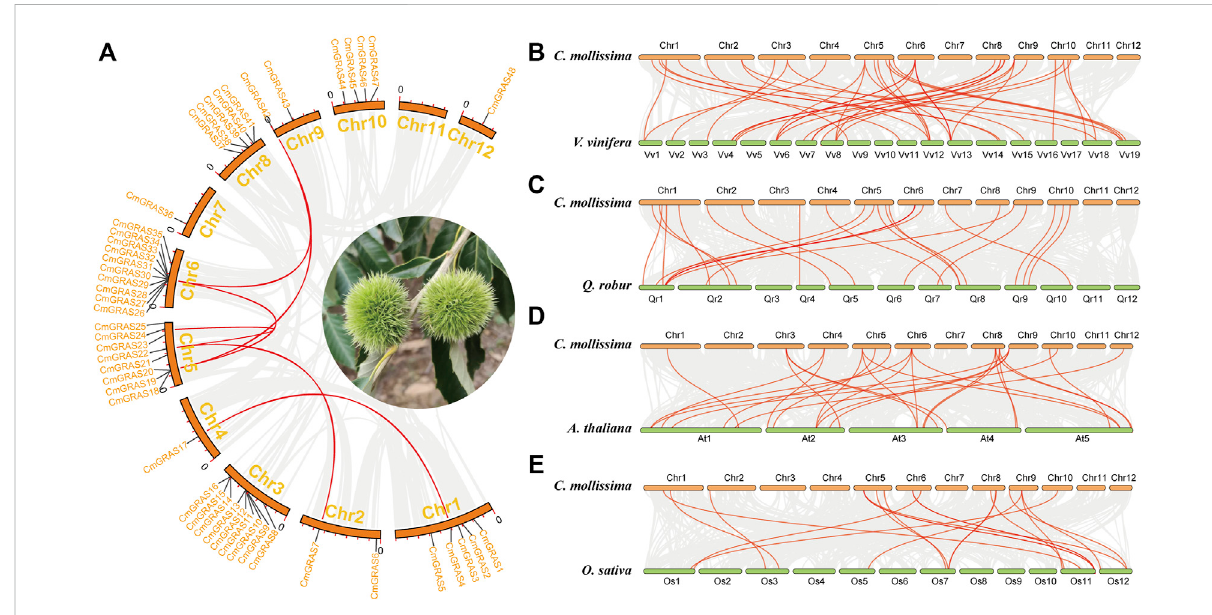
FIGURE 3 Collinear relationships within Chinese chestnut genome and with the grape, oak, Arabidopsis thaliana and rice genomes. (A) Collinear relationship within Chinese chestnut genome. (B) Collinear relationship between Chinese chestnut and grape genomes. (C) Collinear relationship between Chinese chestnut and oak genomes. (D) Collinear relationship between Chinese chestnut and Arabidopsis thaliana genomes. (E) Collinear relationship between Chinese chestnut and rice